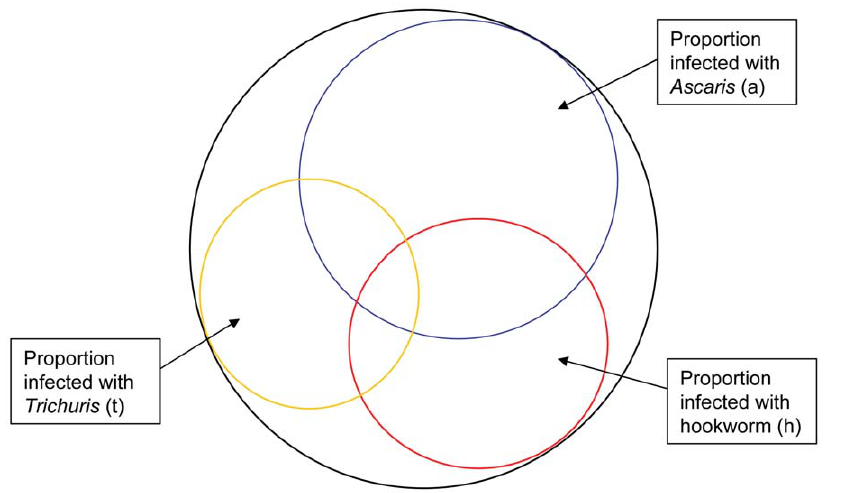
Figure 1. A diagrammatic representation of the permutation of infections with Ascarislumbricoides , Trichuristrichiura and hookworm in a community in which all three occur.